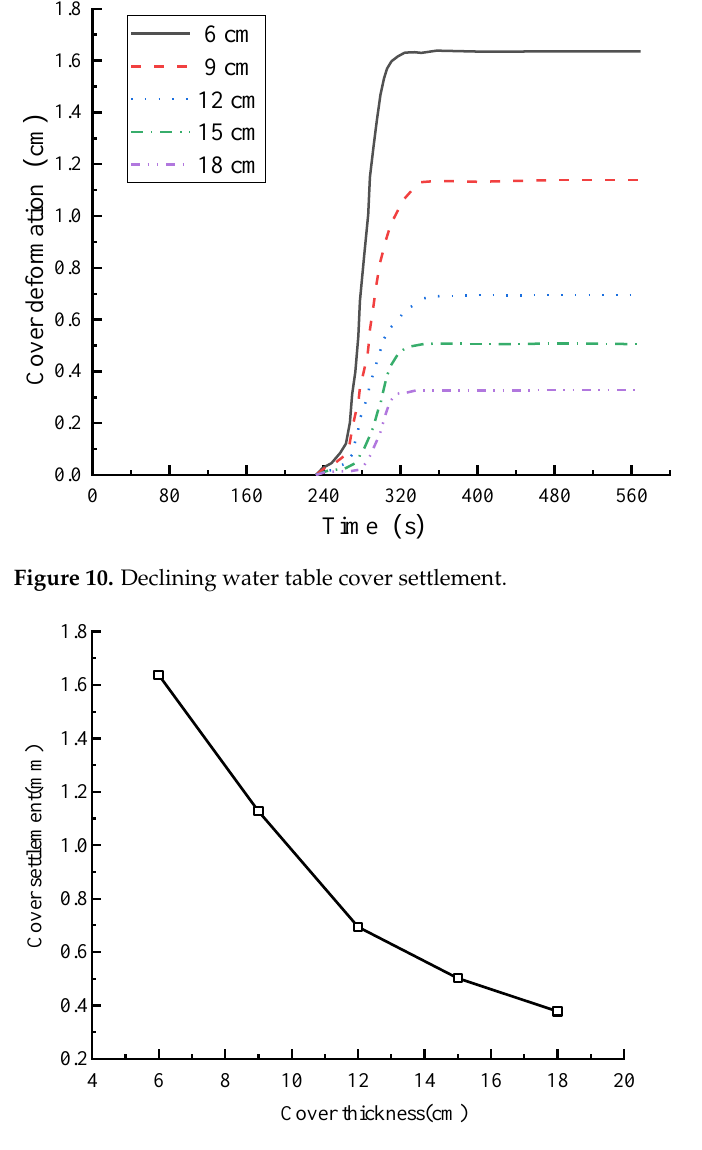
Figure 11. Settlement curves for each cover layer as the water level drops